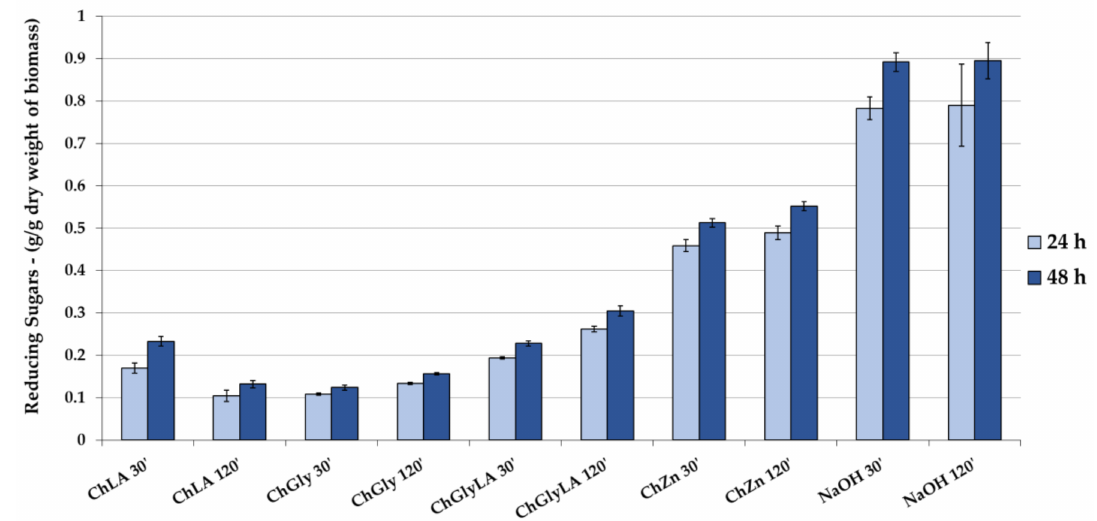
Figure 6. Enzymatic hydrolysis (EH) of solid fractions, resulting from microwave (MW)-assisted treatment of NaDESs. Yields are expressed as reducing sugars for 24 h and 48 h. Sample treated with NaOH is reported as a benchmark. Y-axis refers to dry delignified